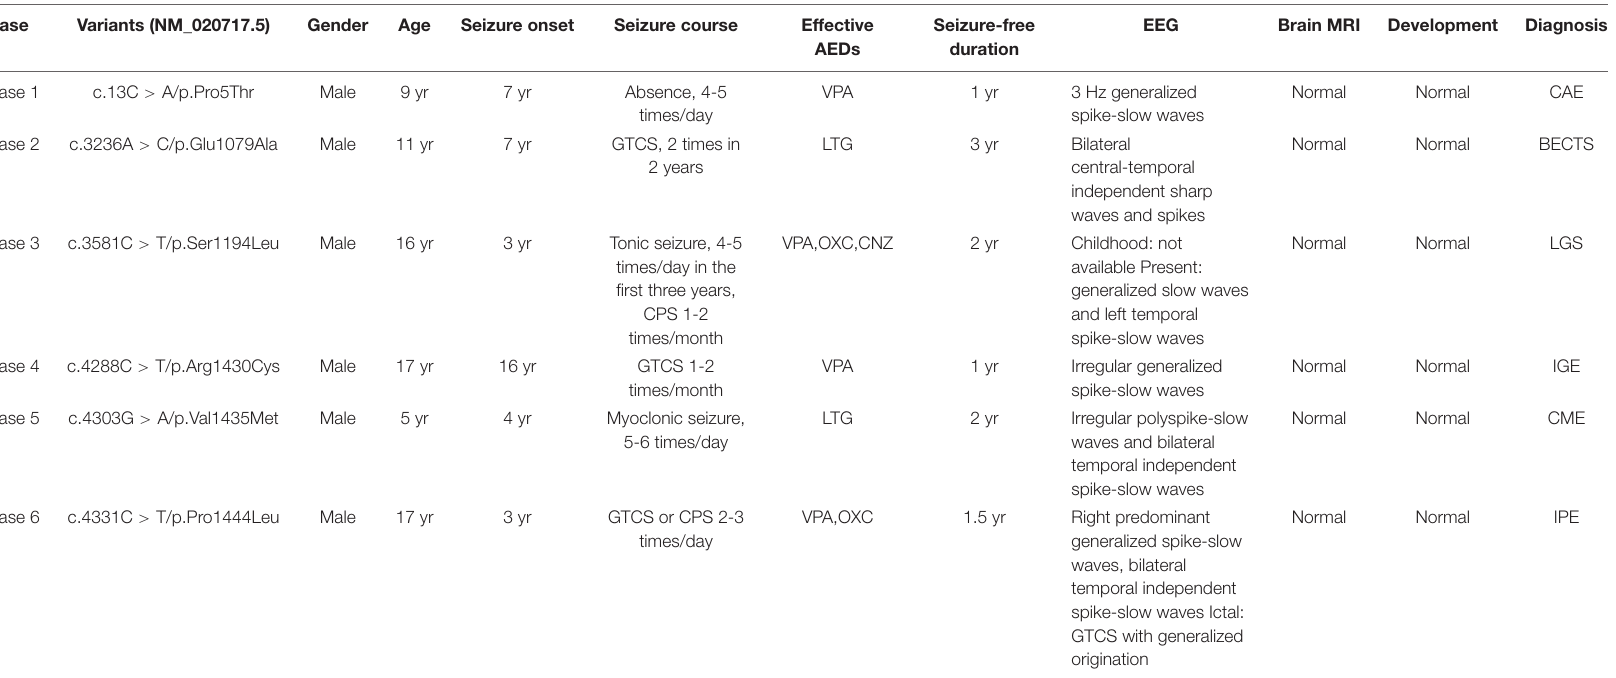
TABLE 1 | Clinical features of the individuals with SHROOM4